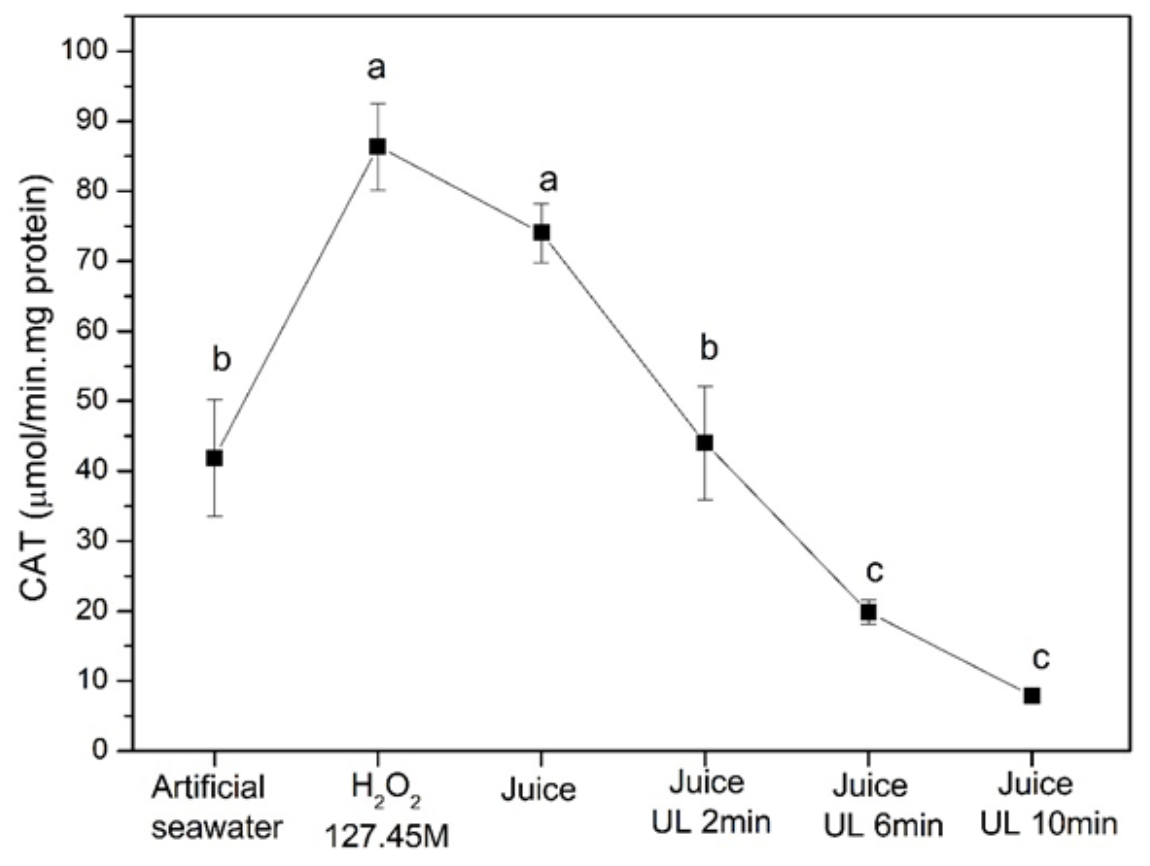
Figure 9. Catalase (CAT) activity of unprocessed sapota-do-Solimões juice and processed by ultrasound (1000 μg·mL −1 ) on Artemia salina nauplii after 72 h of H 2 O 2 exposure. The different letters indicate statistically significant differences ( p ≤ 0.05).